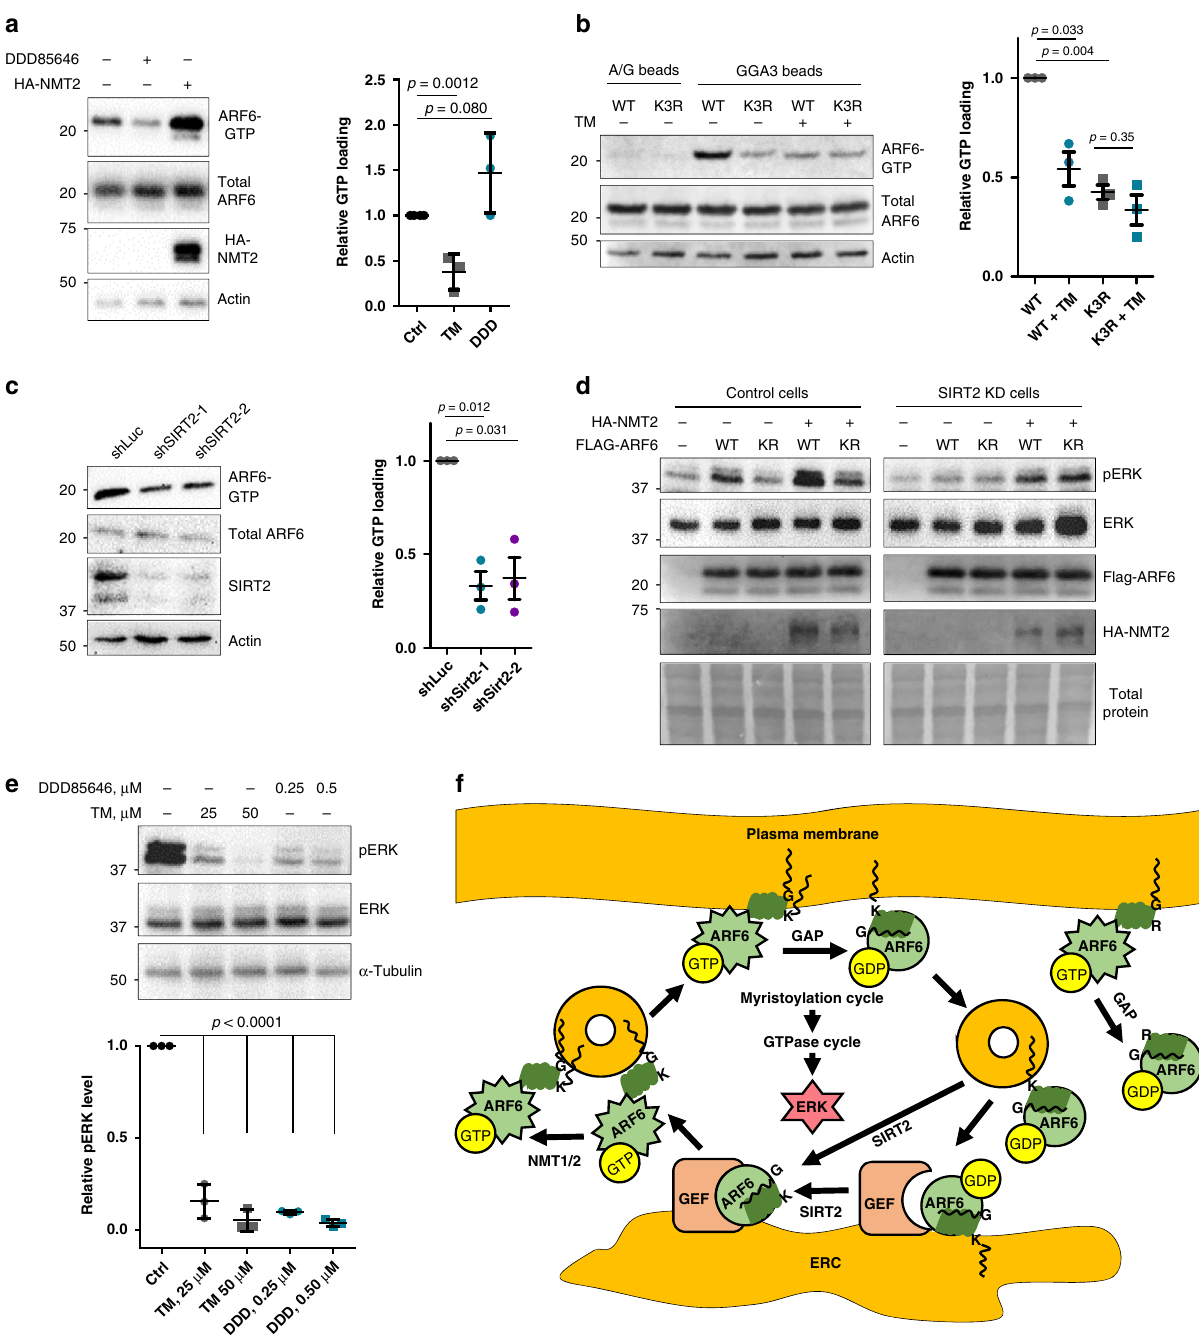
Fig. 7 Lysine myristoylation cycle regulates ARF6 activation to control ERK phosphorylation. a NMT inhibition with DDD85646 suppresses, but NMT2 OE promotes, ARF6 GTP loading. GGA3 pull down in cells expressing Flag-ARF6 and subjected to NMT2 OE or NMTi. n = 3. b GGA3 pull down showing that SIRT2 inhibition by TM decreases the GTP loading of ARF6 WT, but not K3R. n = 3. c SIRT2 KD inhibits GTP loading of endogenous ARF6. GGA3 pull down was performed in HEK293T cells with transient SIRT2 KD. n = 3. d ARF6 lysine myristoylation promotes pERK in control but not in SIRT2 KD HEK293T cells. ARF6 WT or K3R mutant were overexpressed in HEK293T cells that were blotted for pERK after 15 h of serum starvation. n = 2 e SIRT2 and NMT inhibition dose-dependently inhibit pERK. HEK293T cells were treated with the indicated inhibitors for 15h. n = 3. For all experiments, error bars represent SEM and n represents biological replicates analyzed by unpaired two-tailed t test. f Model for the coupling of ARF6 myristoylation – demyristoylation cycle and GTPase cycle. NMT myristoylates ARF6-GTP on K3, which targets ARF6 to plasma membrane and retains inactive ARF6 at the membrane after GTP hydrolysis allowing its traf fi cking to ERC via the endocytic pathway. SIRT2 deacylates inactive ARF6 at early endosomes or ERC to allow its ef fi cient activation by GEFs after GDP release. ARF6-GTP on recycling endosomes gets myristoylated on K3 by NMT, which drives its plasma membrane translocation. This cycle in turn controls ERK phosphorylation. ARF6 K3R cannot be myristoylated on K3 and therefore loses its membrane association after GTP hydrolysis, which inhibits its translocation to endomembranes and